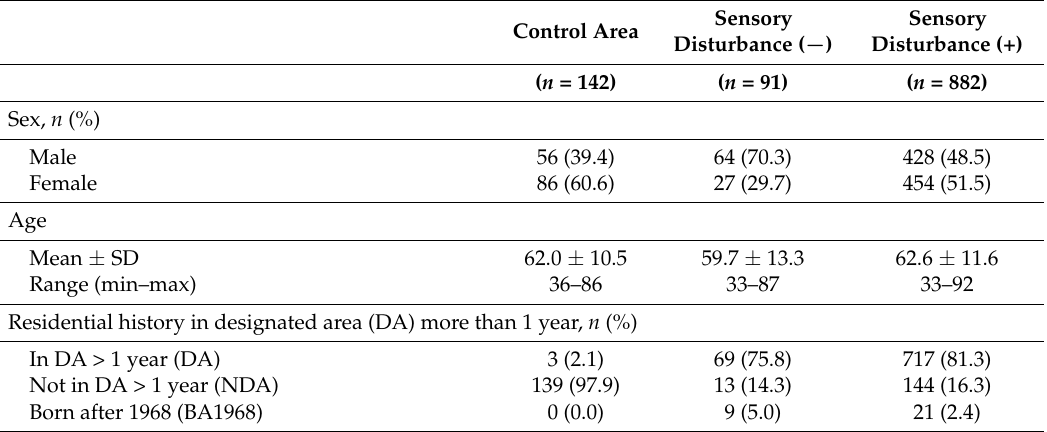
Table 17. Demographic characteristics of subjects in each group ( n = 1115).